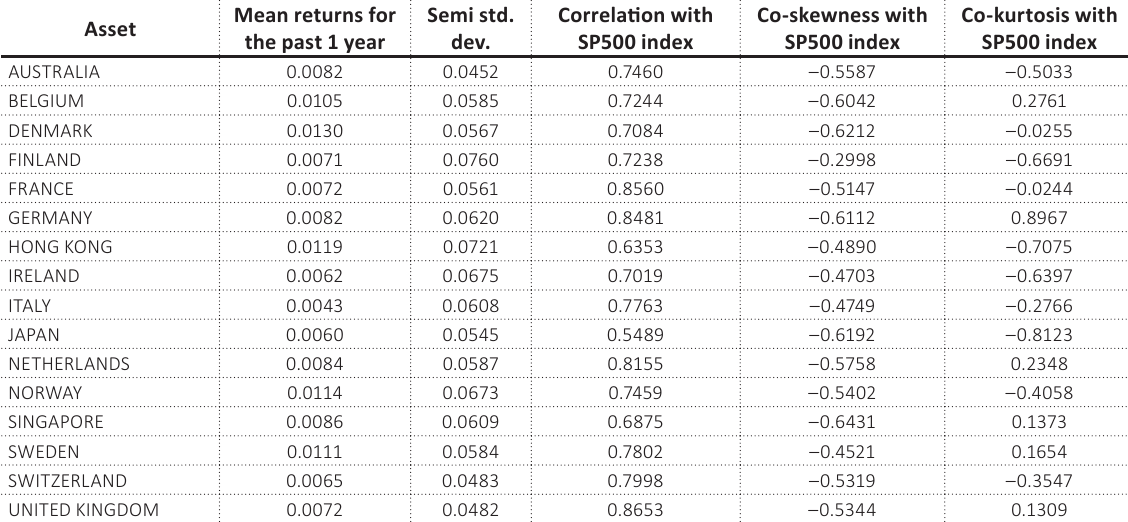
Table 1. Averages of decision criteria for the out-of-sample period Panel A: Developed markets (July 2004 – December